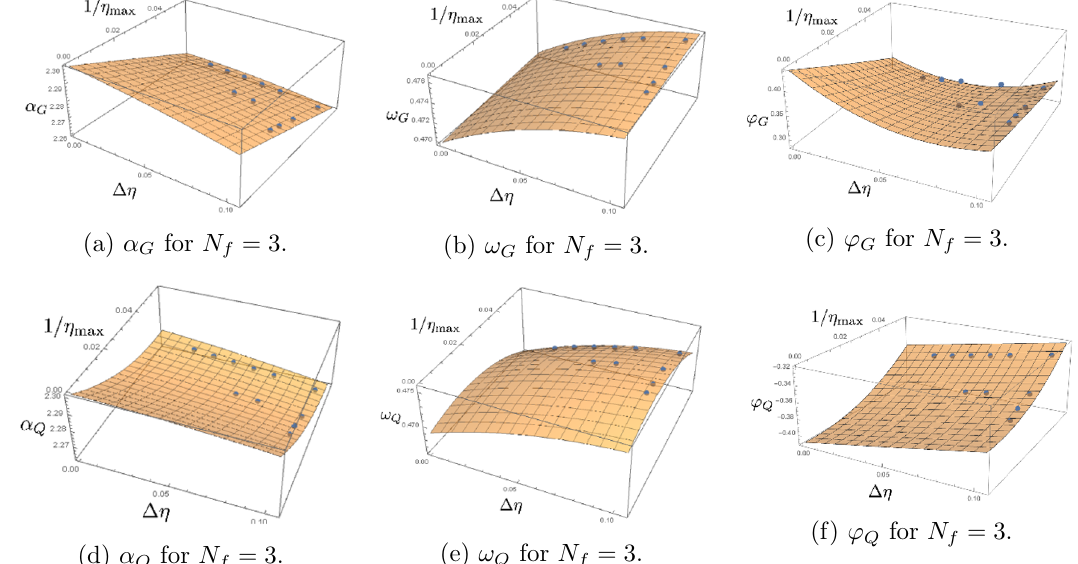
Figure 8 . Plots of parameters (cid:11) G , (cid:11) Q , ! G , ! Q , ’ G and ’ Q as functions of (cid:1) (cid:17) and 1 =(cid:17) max for N f = 3 and N c = 3. The dots represent our numerical evaluation, while the solid surfaces depict the best (cid:12)ts (quadratic in (cid:1) (cid:17) and 1 =(cid:17) max ) used for extrapolating to the continuum asymptotic values at (cid:1) (cid:17) = 0